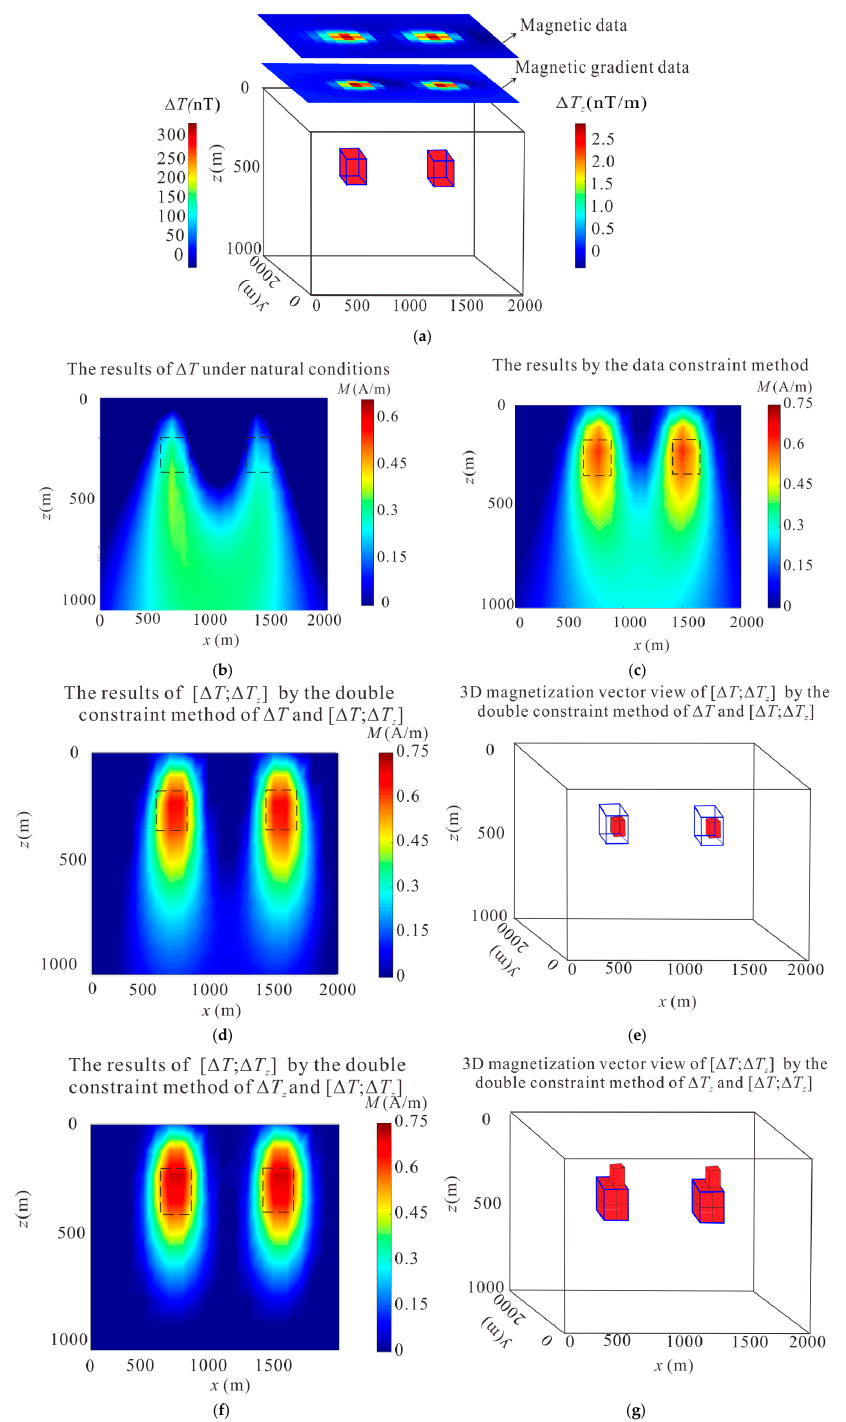
Figure 5. Models with similar depths obtained by the data constraint and double constraints inversion method of CMG data and different components airborne magnetic data. ( a ) Airborne magnetic and gradient anomaly; ( b ) the result of airborne magnetic anomaly under natural conditions; ( c ) the results of CMG data by the data constraint inversion method, with slices corresponding to y = 1000 m; ( d , e ) the results of CMG data with Equation (8) by the double constraints inversion method and corresponding 3D magnetization vector view with a cutoff value 0.471 A/m, with slices corresponding to y = 1000 m; and ( f , g ) the results of CMG data with Equation (10) by the double constraints inversion method and the corresponding 3D magnetization vector view with a cutoff value of 0.471 A/m, with slices corresponding to y = 1000 m.